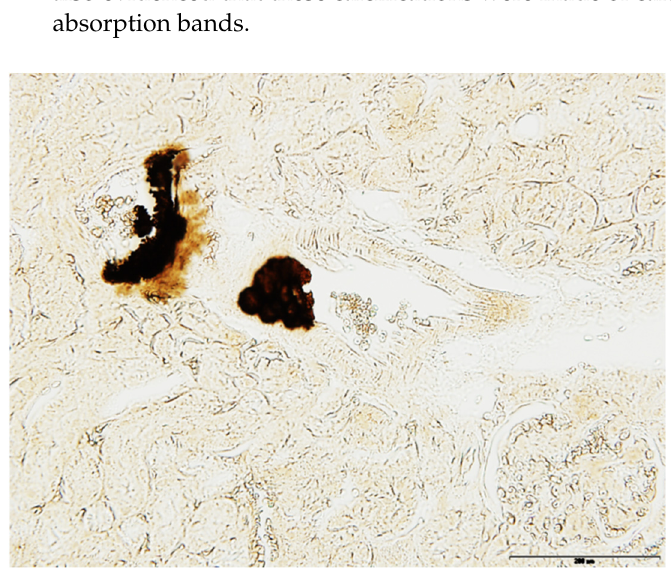
Figure 4. Representative kidney calcifications stained with Yasue method, evidencing arterial calci- fications (in the vascular wall).